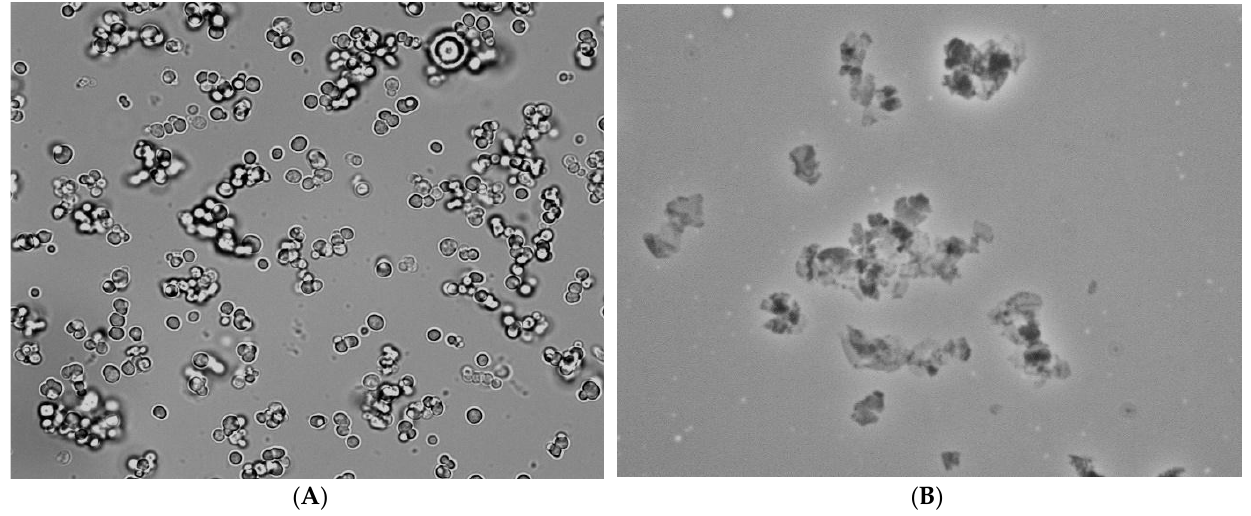
Figure 3. Degradation of the shell of polyelectrolyte microcapsules by proteinase from Streptomyces griseus . ( A ) PMCs before proteinase; ( B ) PMCs after proteinase.